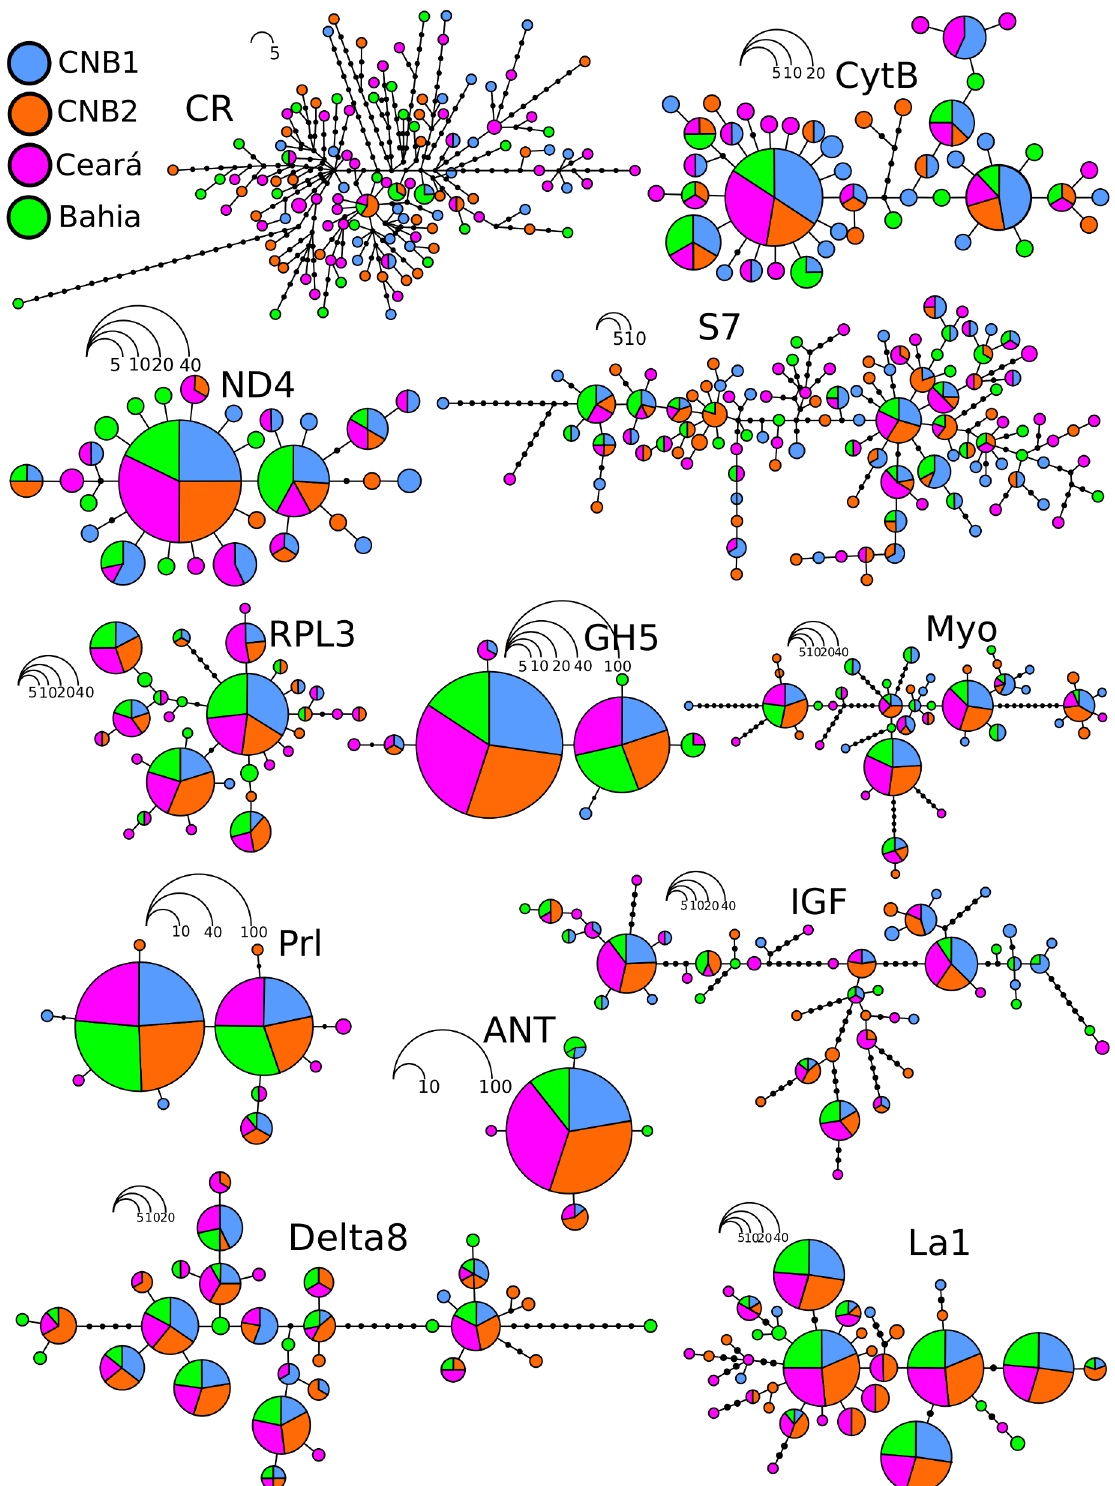
Fig 2. Genealogical relationships between haplotypes of the loci used in this study. Each circle represents a haplotype, and the area is proportional to the frequency of the haplotype. Colors refer to the collection location.